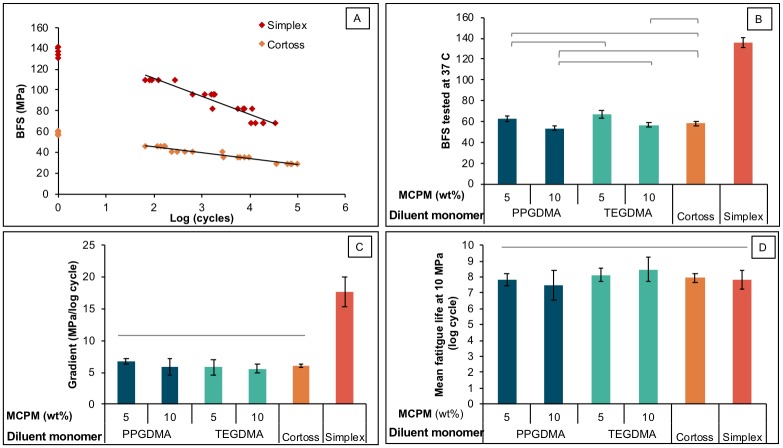
A) BFS tested in SBF at 37°C, B) example plots of BFS versus log (cycle) (n = 20), C) gradients of S/N plots in positive values for clarity purpose, and D) extrapolated fatigue life at BFS of 10 MPa. Lines indicate no significant difference (p > 0.05) and error bars are SD (n = 5).